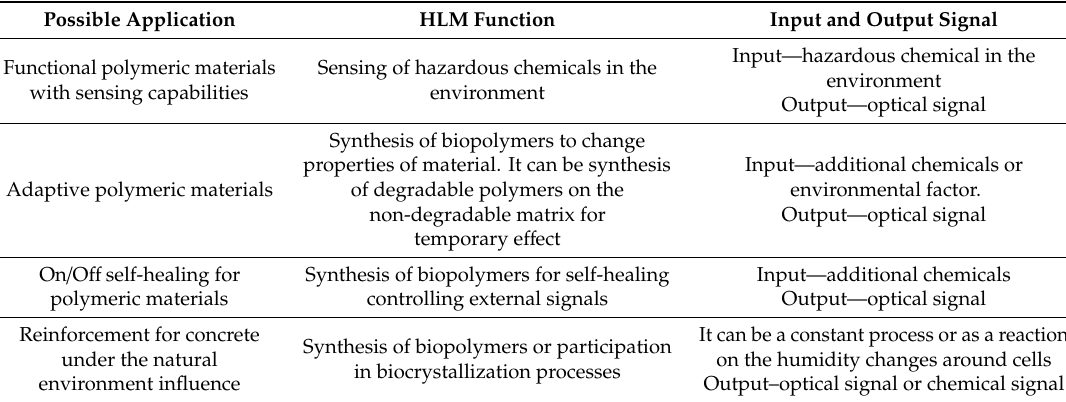
Table 2. Possible applications of hybrid living materials